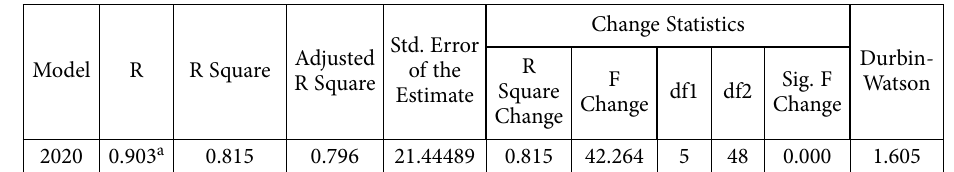
Table 13. Seasonal sustainability function for